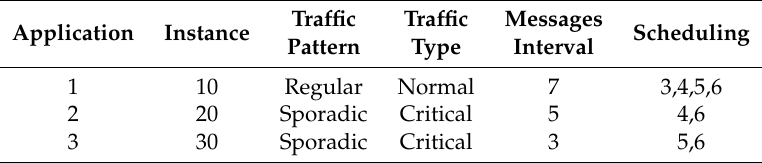
Table 4. Scheduling of DYNASTI with three applications.